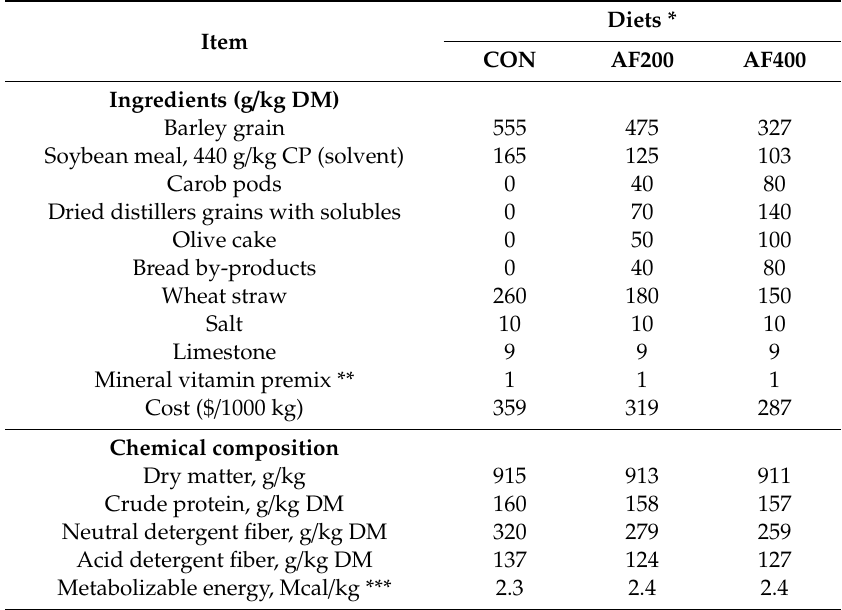
Table 2. Ingredients, cost and chemical composition of diets containing alternative feeds (AF) for lactating Awassi ewes and